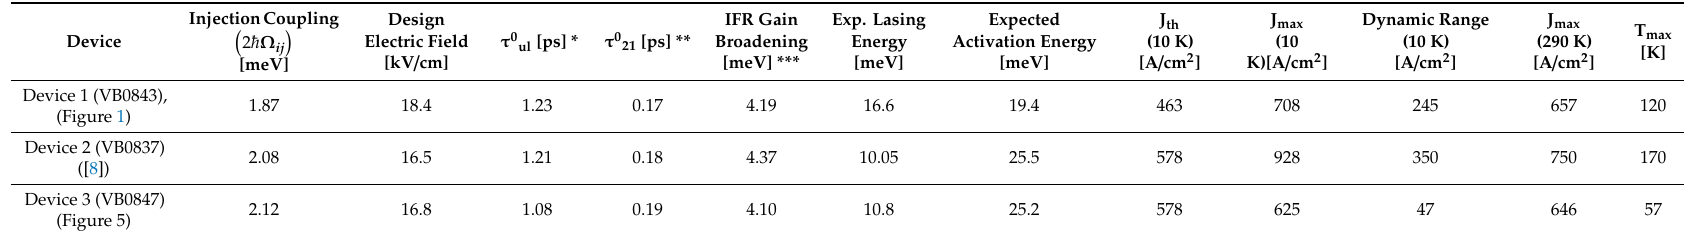
Table 2. Device parameters and